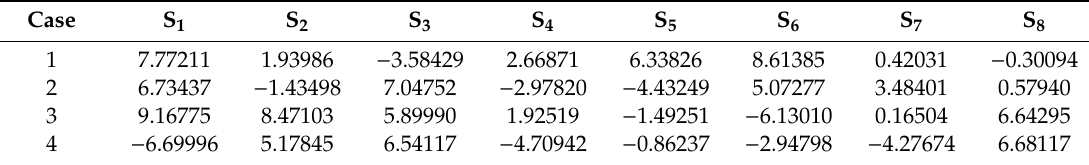
Table 2. Four groups of di ff erent locomotive power data in eight supply power sections (MW).